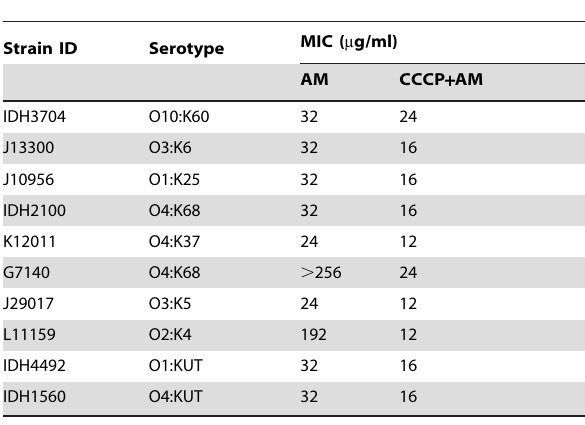
Table 2. MICs of ampicillin in presence/absence of CCCP.